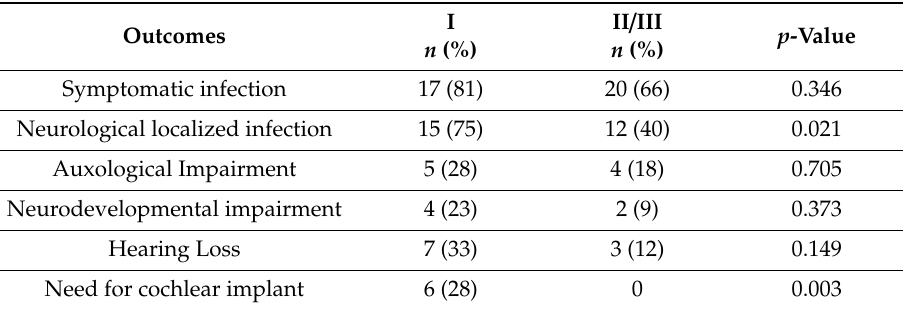
Table 4. Di ff erences between trimester.